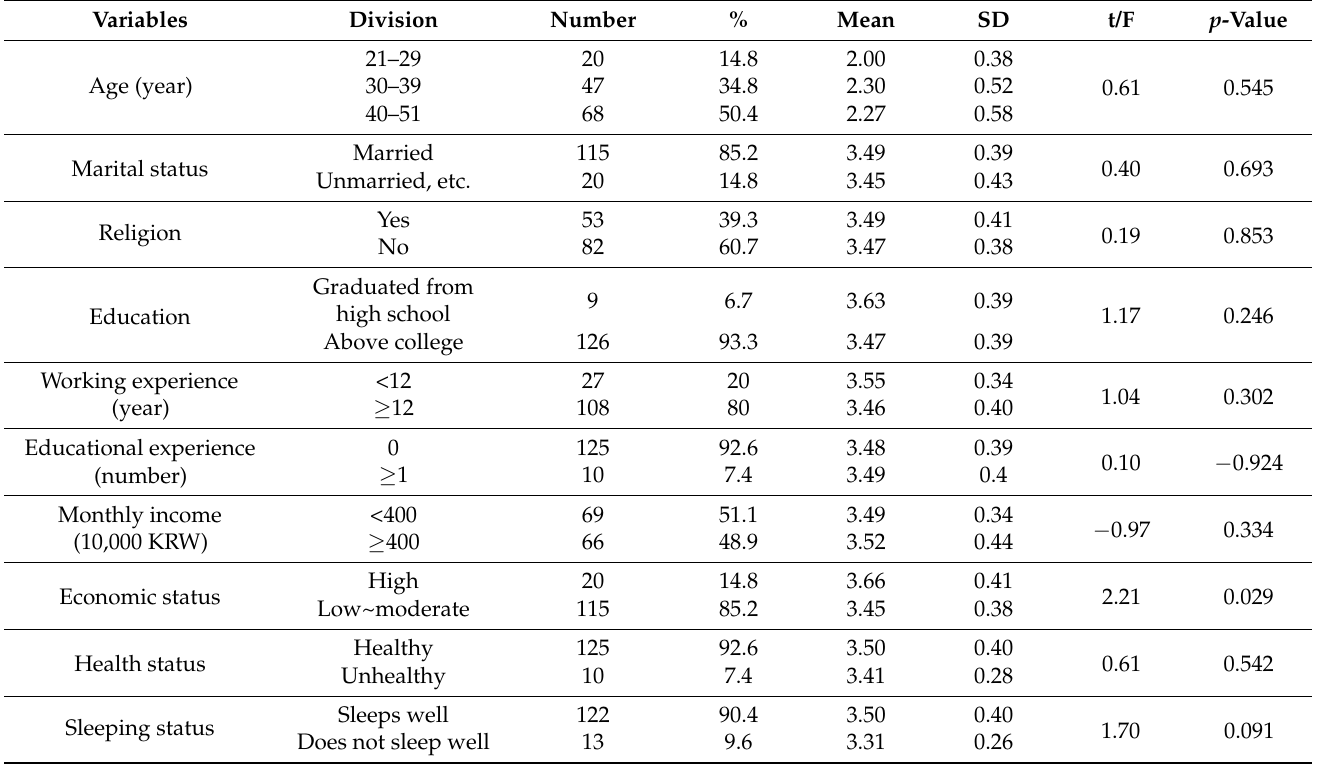
Table 1. Differences in psychological well-being according to general characteristics (N =